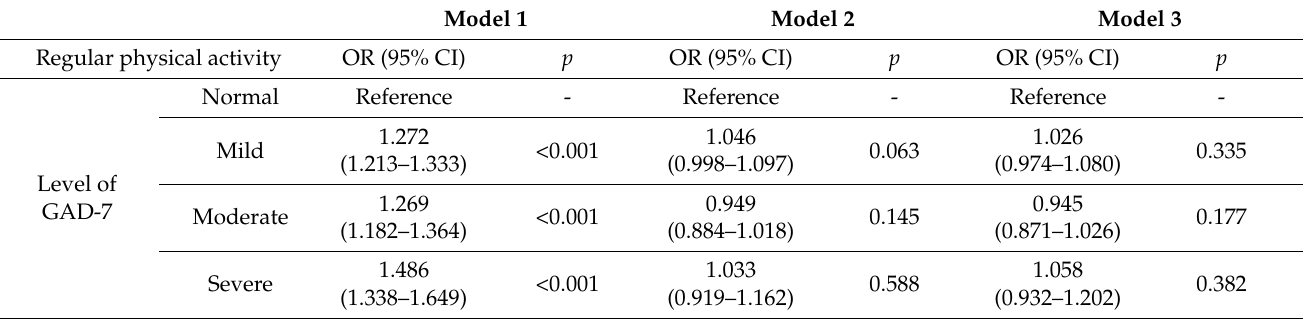
Table 7. Logistic regression analysis to level of GAD-7 based on regular physical